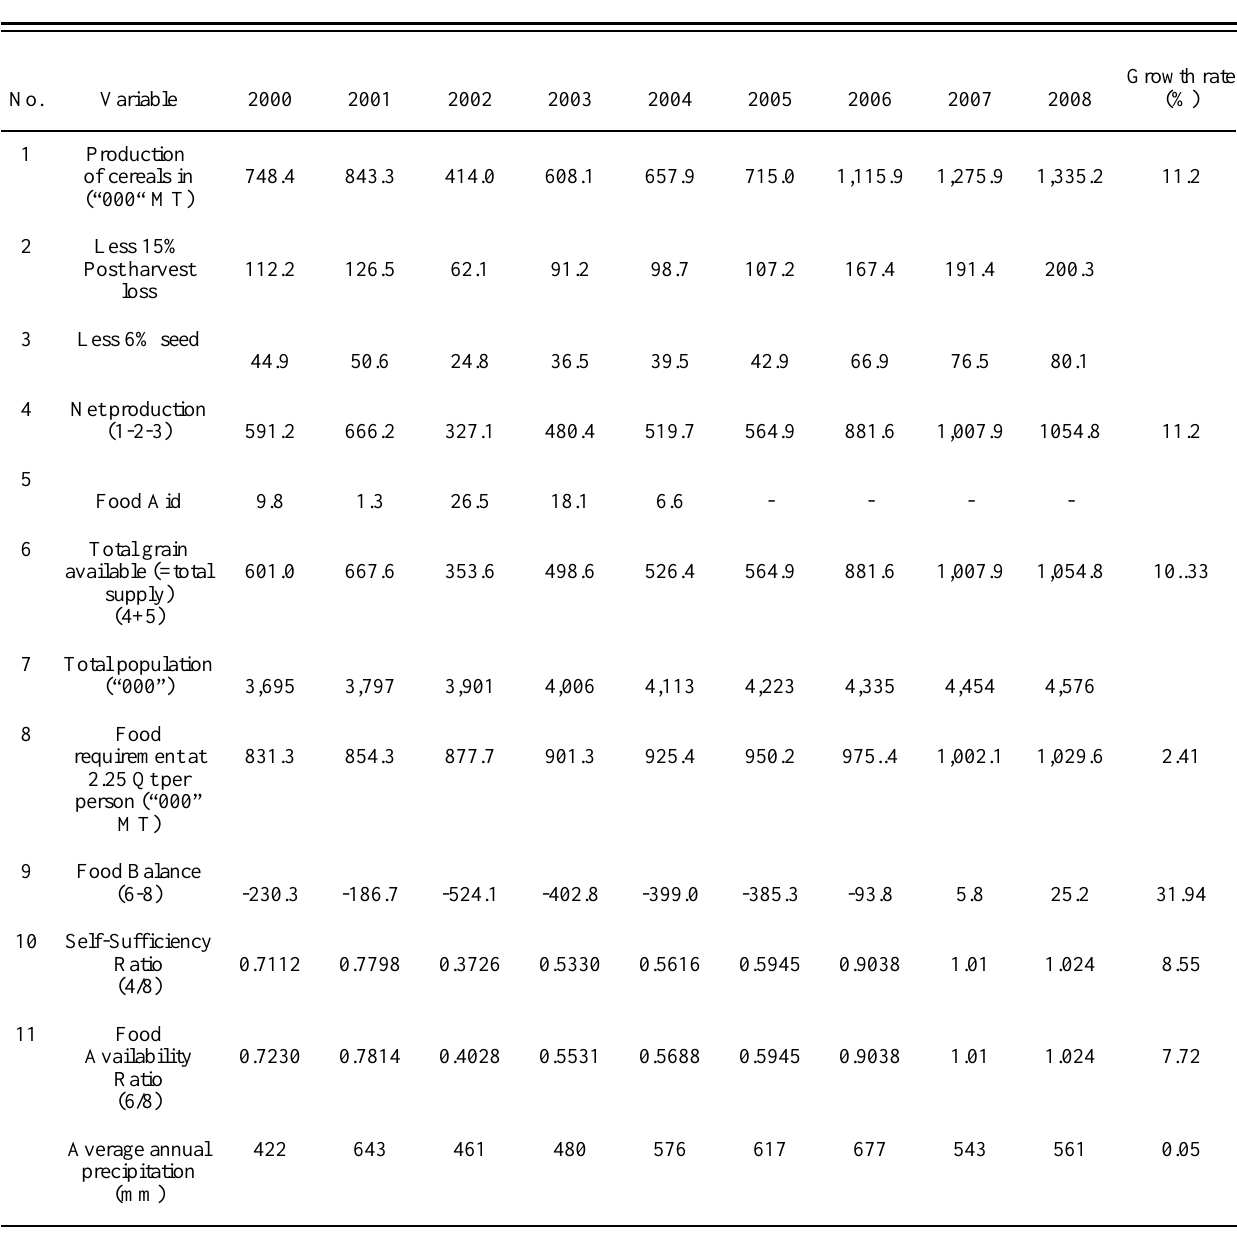
Table 1 . Food Balance Sheet for Tigray Region, 2000 –